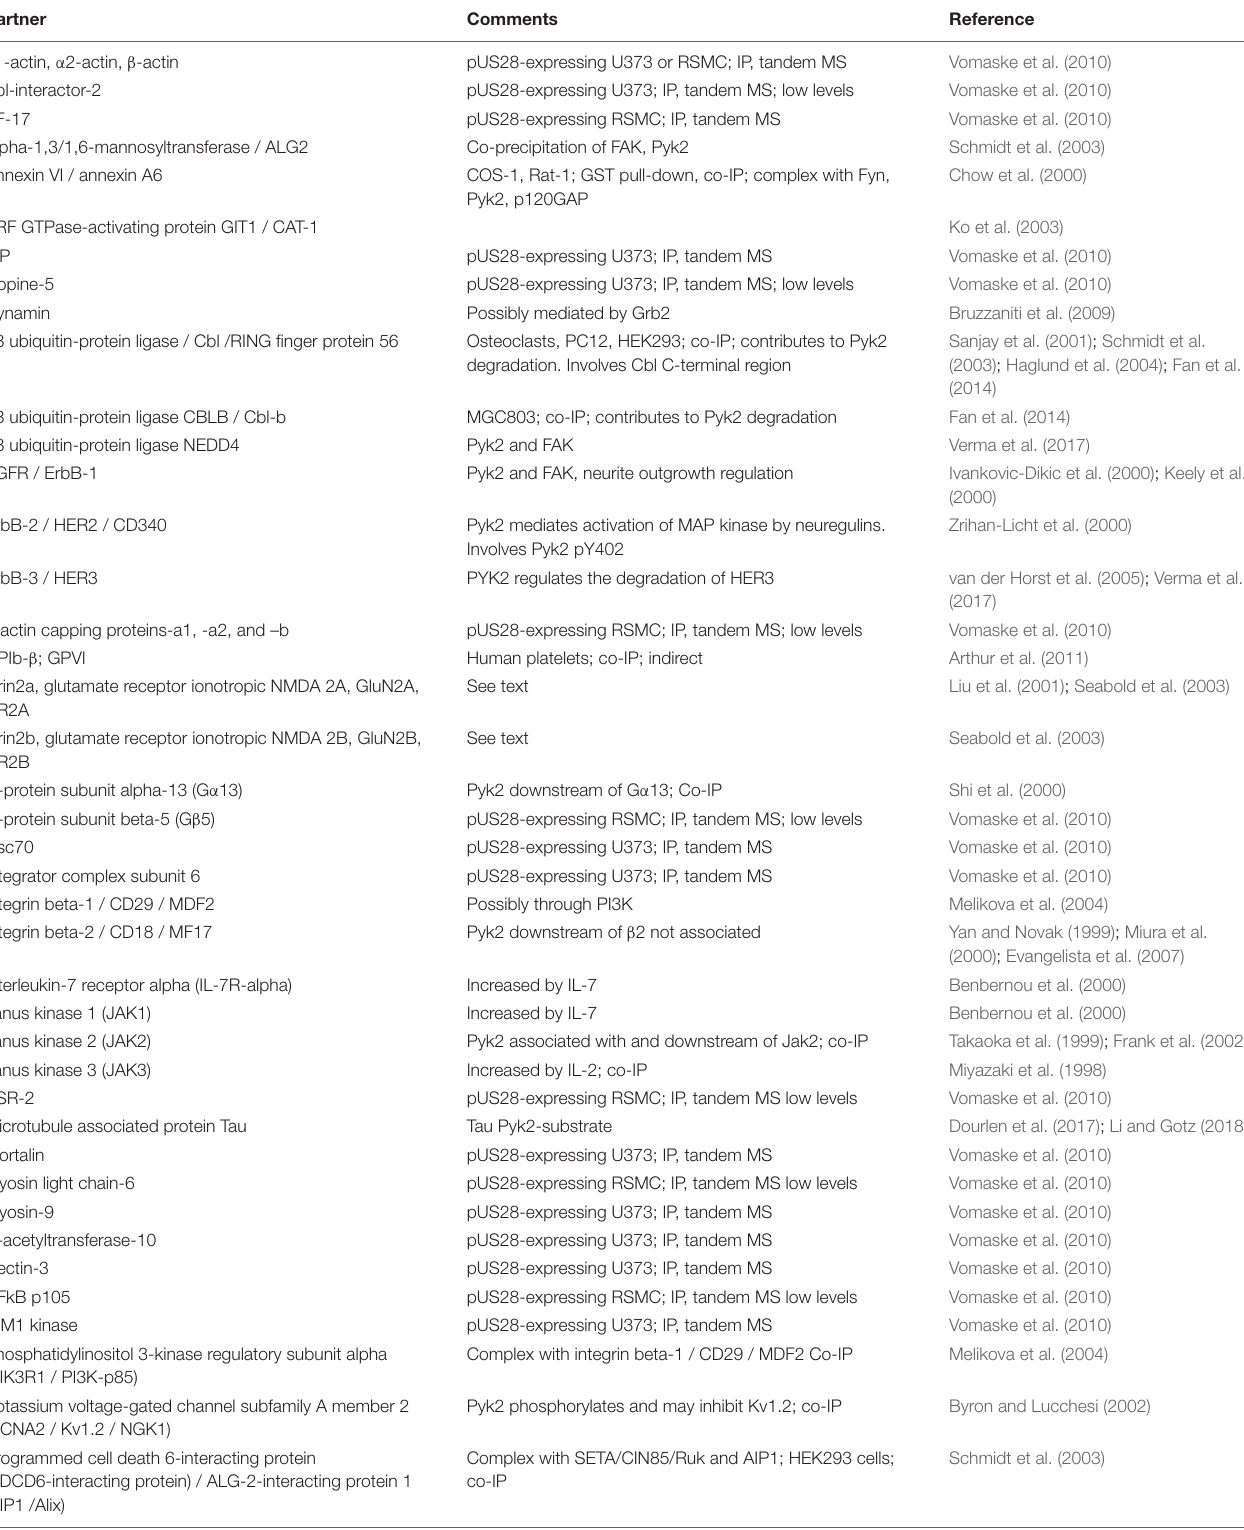
TABLE 2 | Protein partners possibly interacting indirectly with